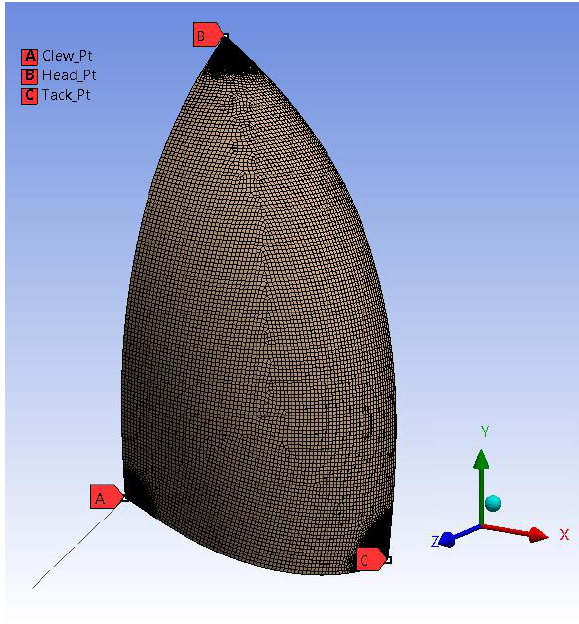
Figure 12 . FEM mesh of the sail. Figure 12. FEM mesh of the